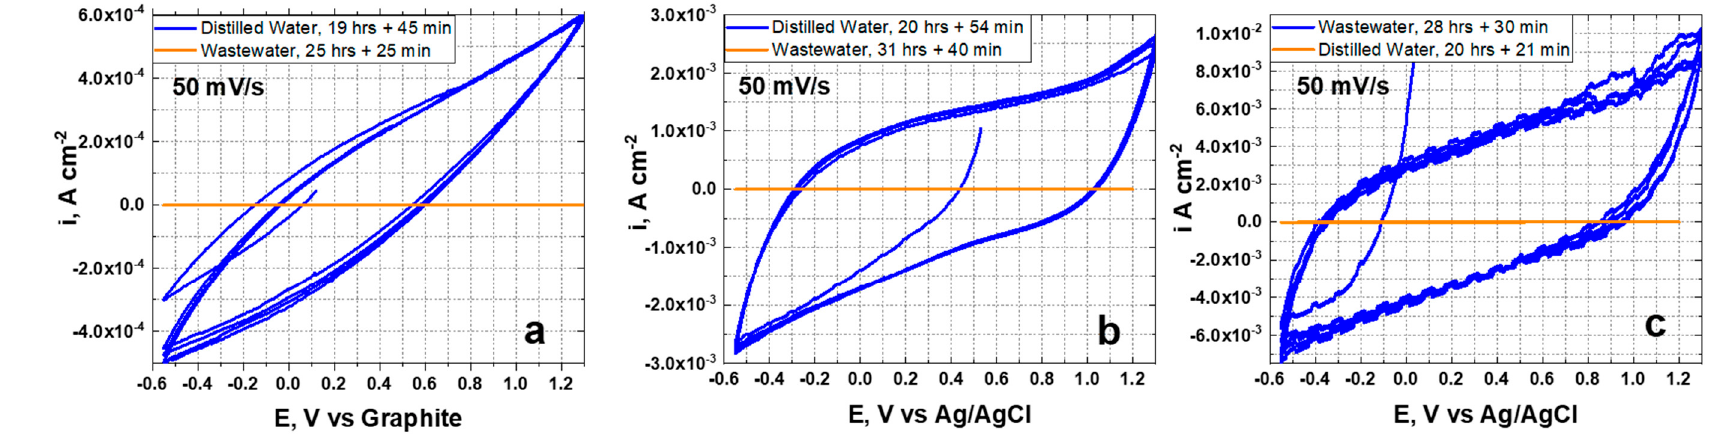
Figure 5. S 2: Electrochemical behavior of the MFC during degradation of domestic wastewater under vacuum conditions at 50 mV / s under cathode direction. Domestic wastewater was degraded in the anode chamber. In a parallel system, distilled water replaced wastewater in the anode chamber. In the cathode chamber of both systems the electrolyte (0.1 M HCl, pH ≈ 1.8) was used. Voltammograms ( a ), ( b ) and ( c ), correspond to the potentiostat settings A, B and C, respectively.